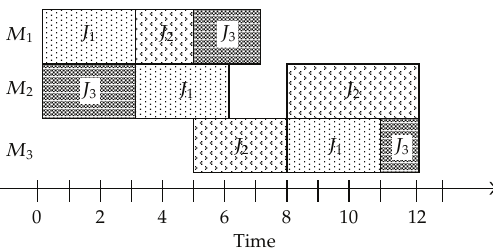
Figure 1: A Gantt chart representation of a solution for a 3 ∗ 3 problem.